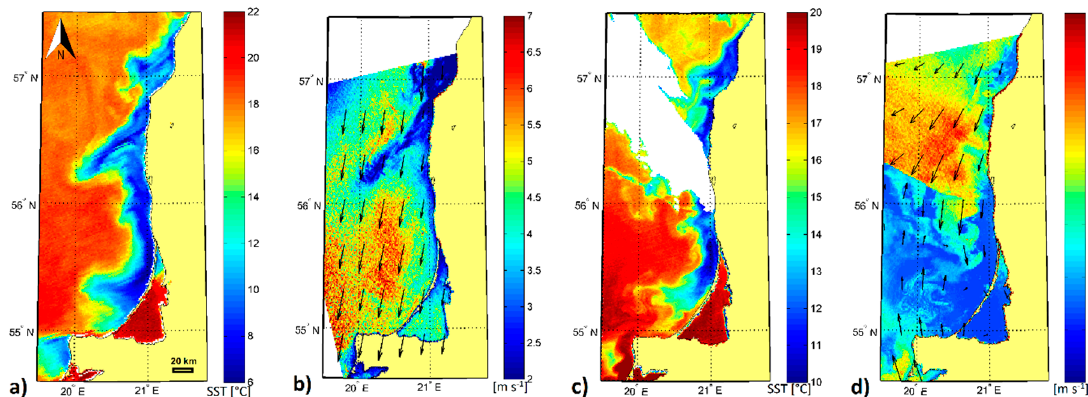
Figure 16. Upwelling impact on the near-surface wind field in the SE Baltic Sea. ( a ) MODIS/Aqua SST map of 16 July 2006 (19:40 UTC); ( b ) synthetic aperture radar (SAR)-derived near-surface wind field of 16 July 2006 (20:05 UTC); ( c ) same as ( a ), but for 19 July 2006 (20:10 UTC); ( d ) same as ( b ), but for 19 July 2006 (20:11 UTC).